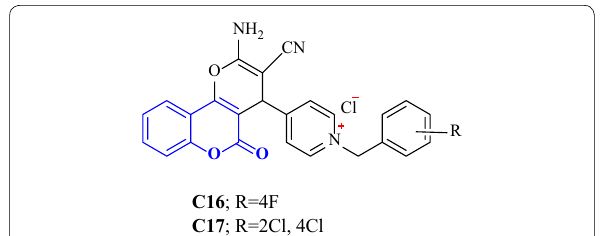
Fig. 23 Chemical structures for 5-oxo-4,5-dihydropyrano coumarin derivatives